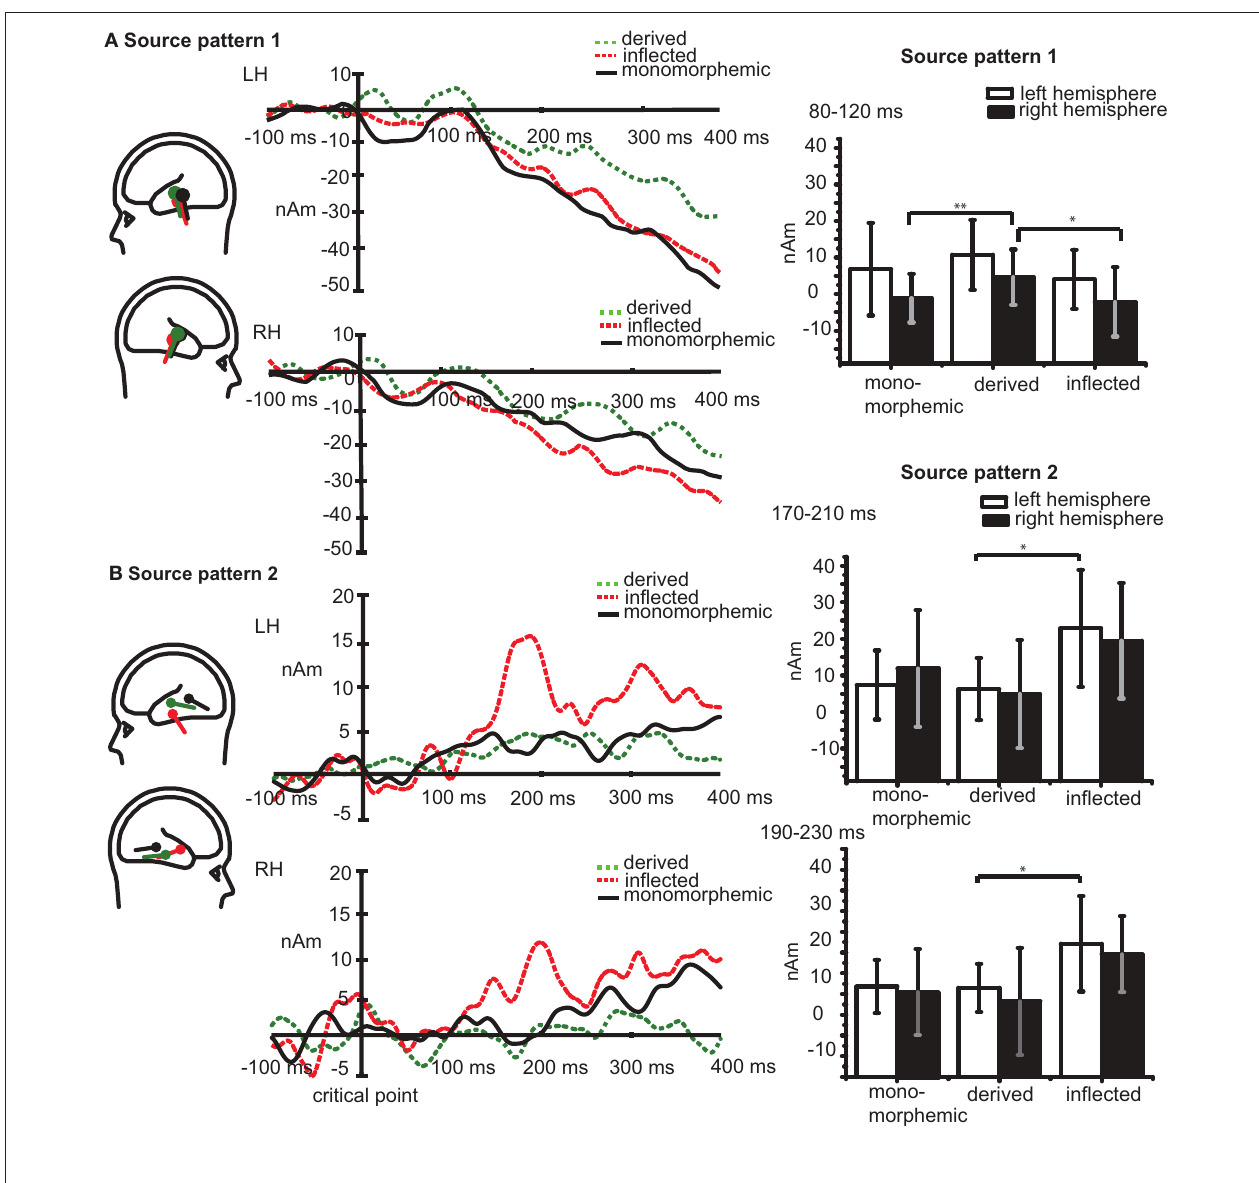
FiGuRE 6 | (Left) mean source waveforms for Source patterns 1 (above) and 2 (below) in the left and right hemisphere for monomorphemic, derived, and inflected words. (Right) mean source amplitudes (columns) and SD (error bars) for monomorphemic, derived, and inflected words for Source